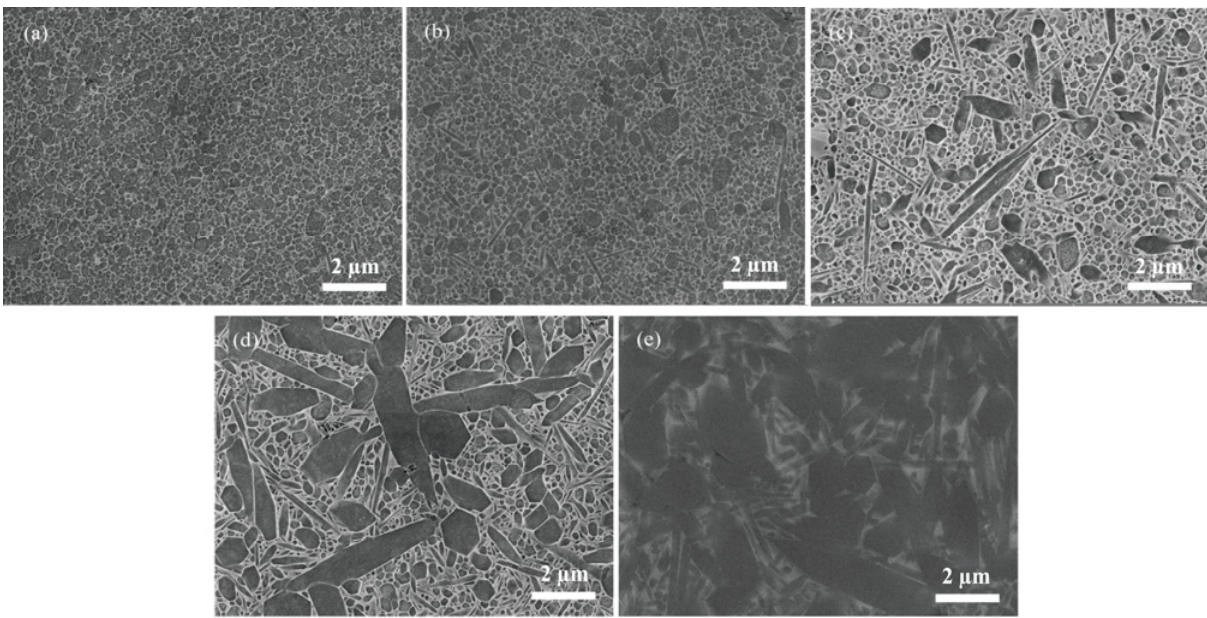
Fig. 2 SEM images of plasma-etched surfaces of the SPSed Si 3 N 4 ceramics: (a) SN1500, (b) SN1600, (c) SN1650, (d) SN1700, and (e) SN1800.